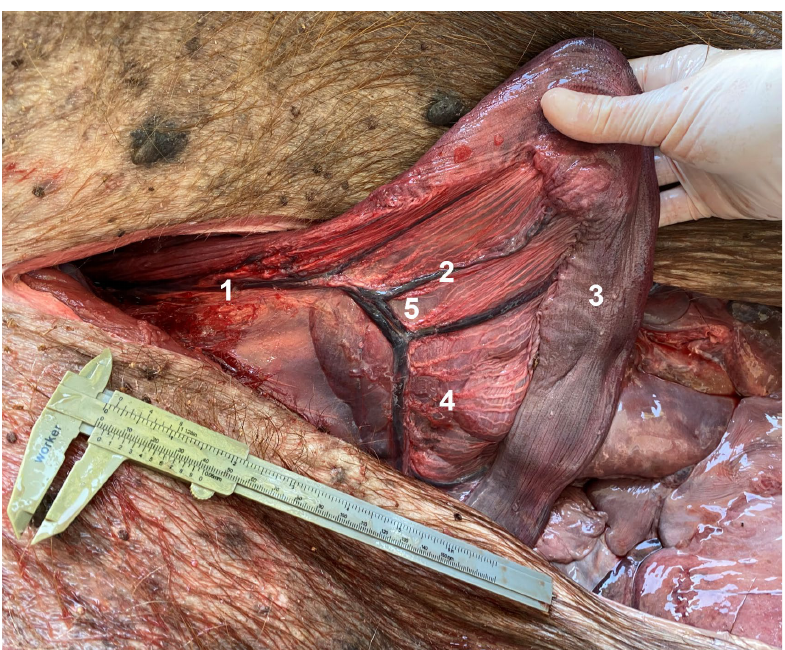
Figure 9. Vascular anatomy of reproductive organs, left approach. 1. uterine tube; 2. ovary; 3. ovarian vein giving rise to the tubal branch (4) and uterine branch (5) that anastomoses with the uterine vein (6); 7. left uterine horn; 8. suspensory ligament of the ovary.